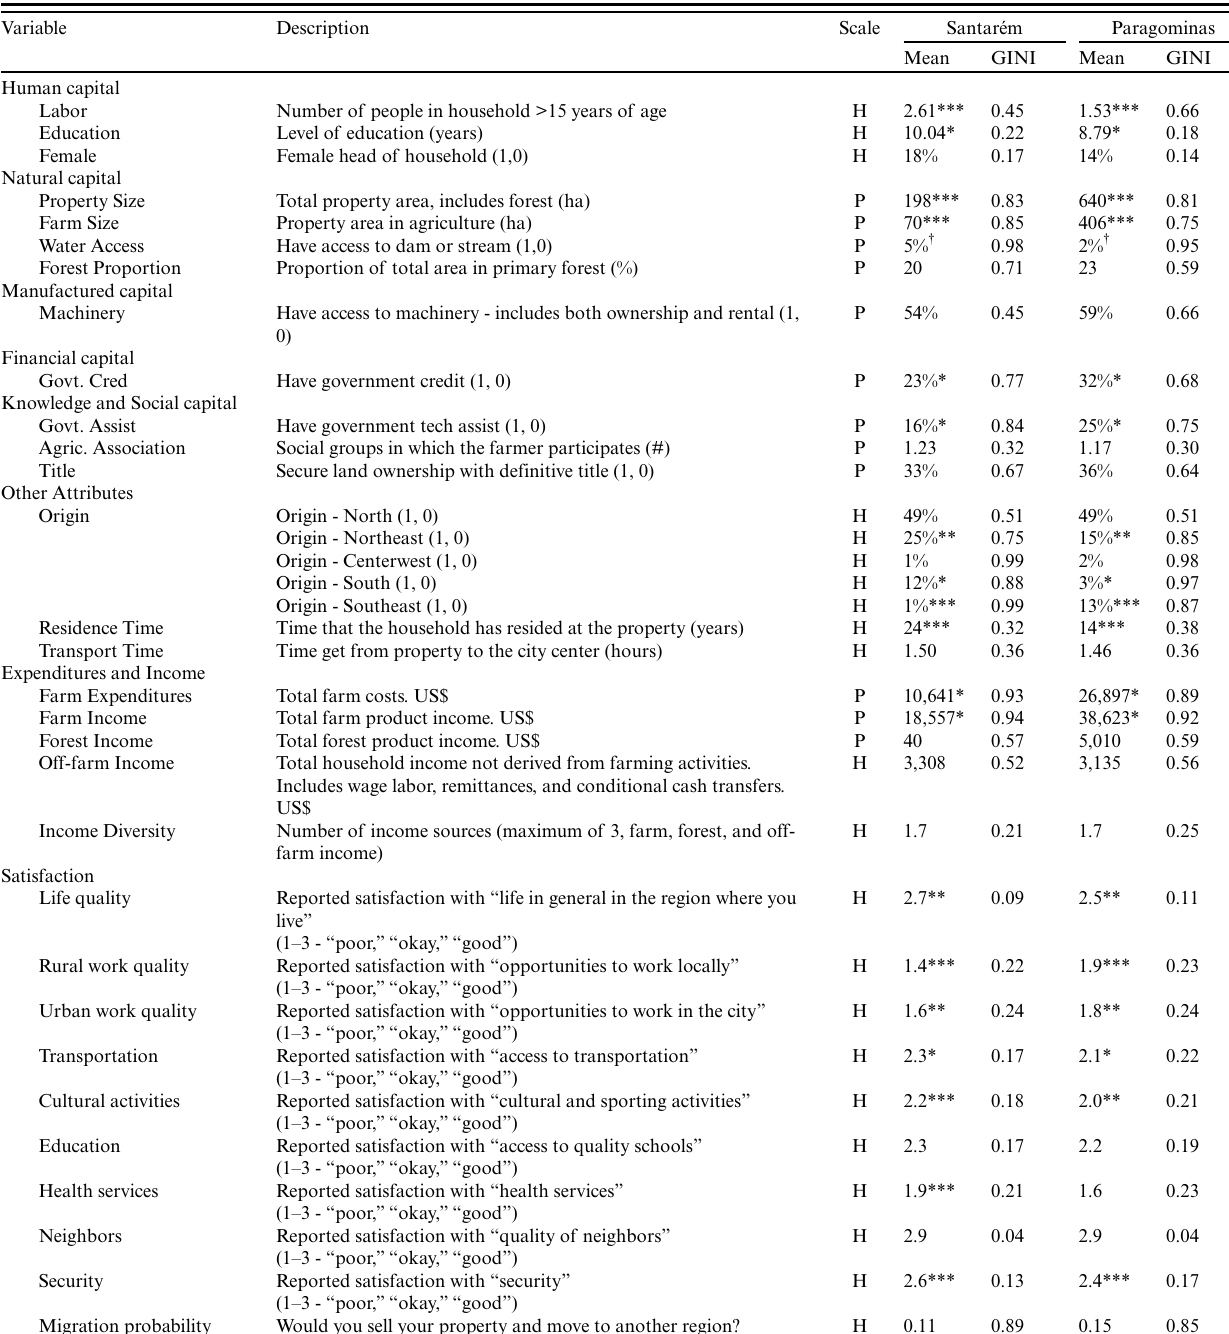
Table 1. Distributions and descriptive statistics for all explanatory variables analyzed in this